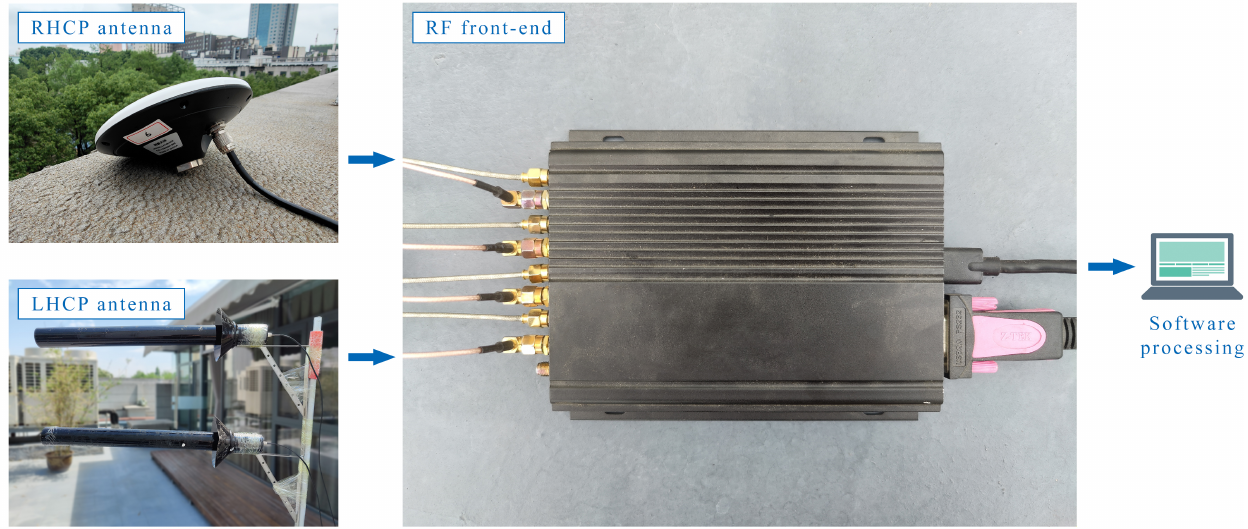
Figure 2. Data acquisition devices: antennas, hardware front end and computer served as software